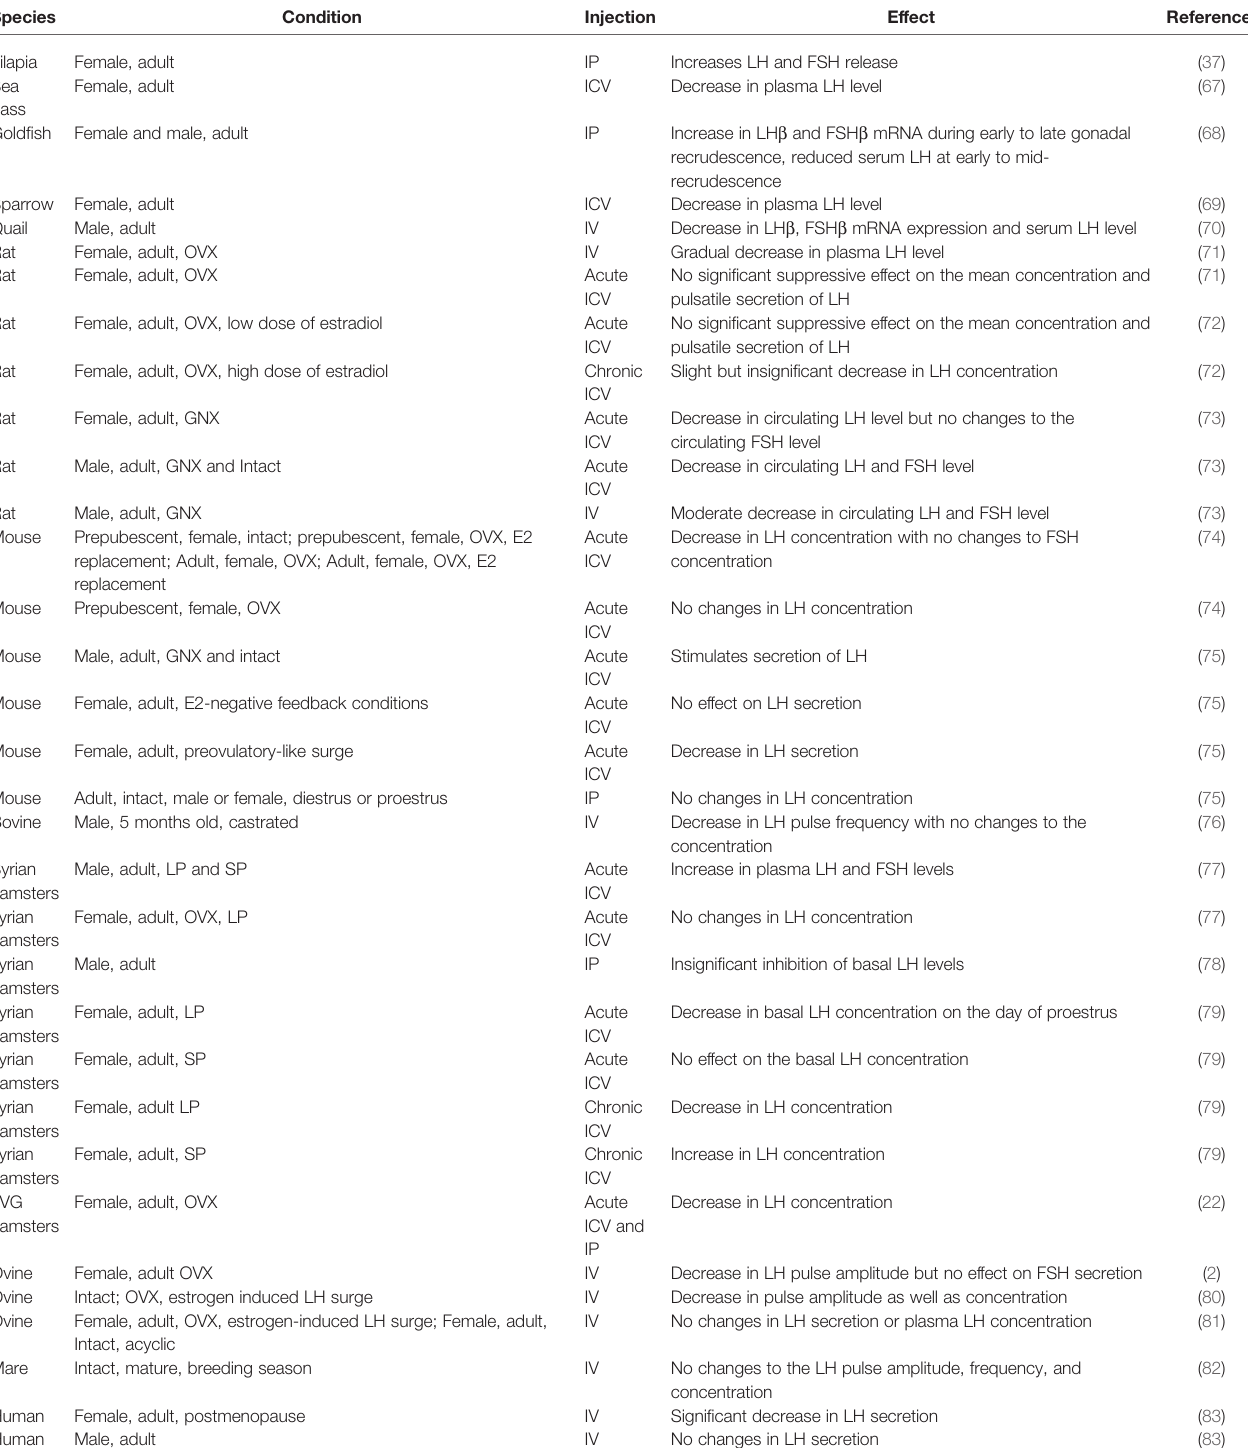
TABLE 2 | Summary of in vivo effects of GnIH/RFRP-3 injection on LH and FSH